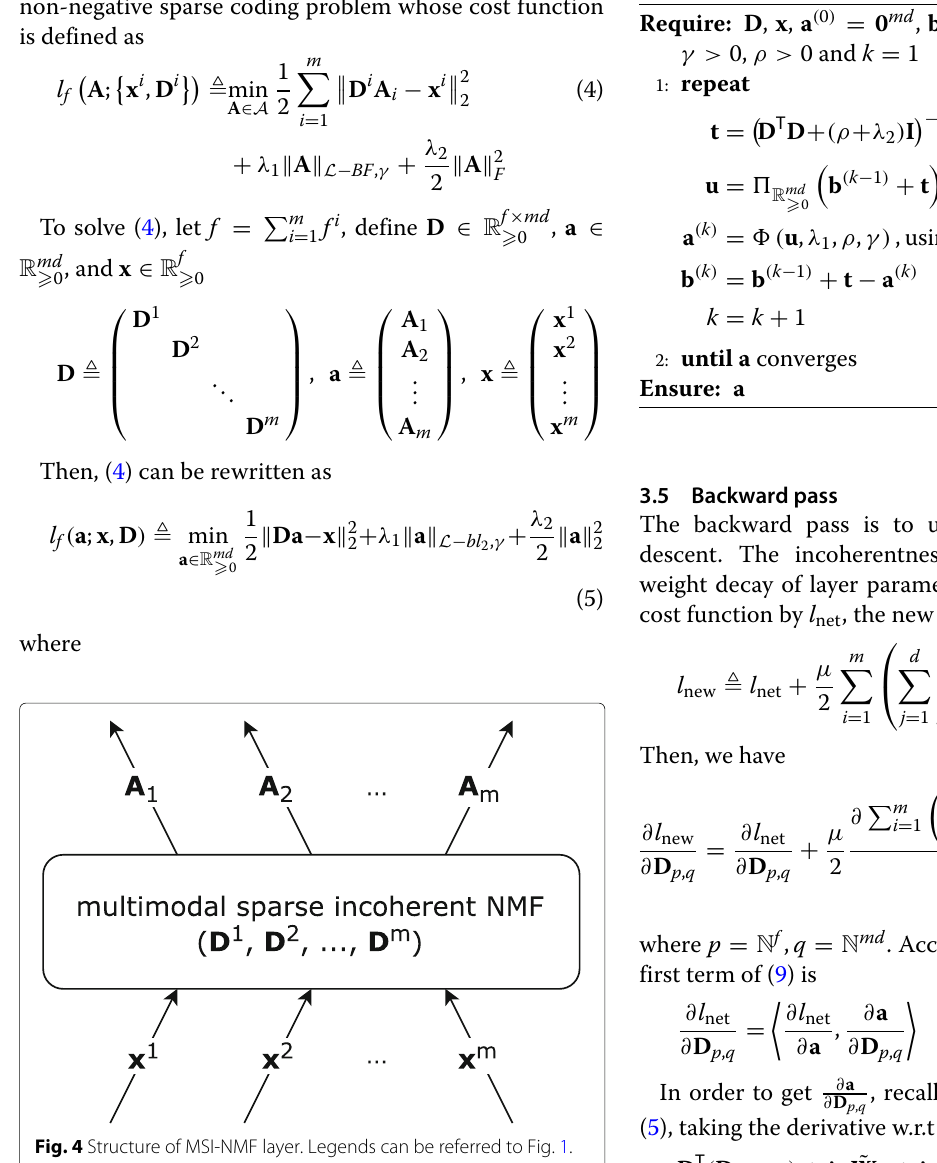
Algorithm 1 (proofs in Appendix), where (cid:7) is given in Algorithm 2. Algorithm 1 Forward Pass of Multimodal Sparse